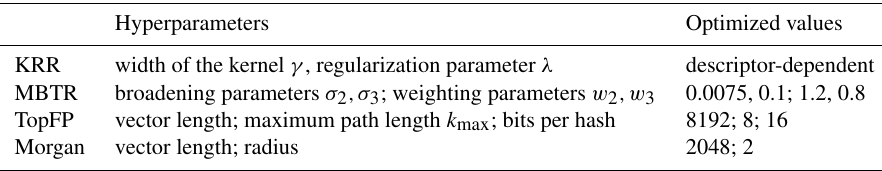
Table 1. All the hyperparameters that were optimized.